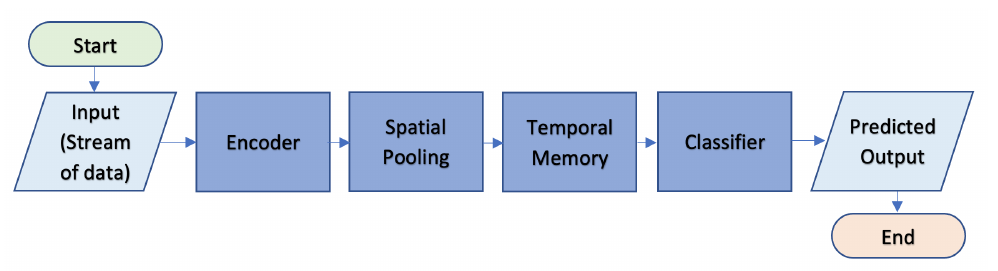
Figure 2. Hierarchical Temporal Memory (HTM) algorithm